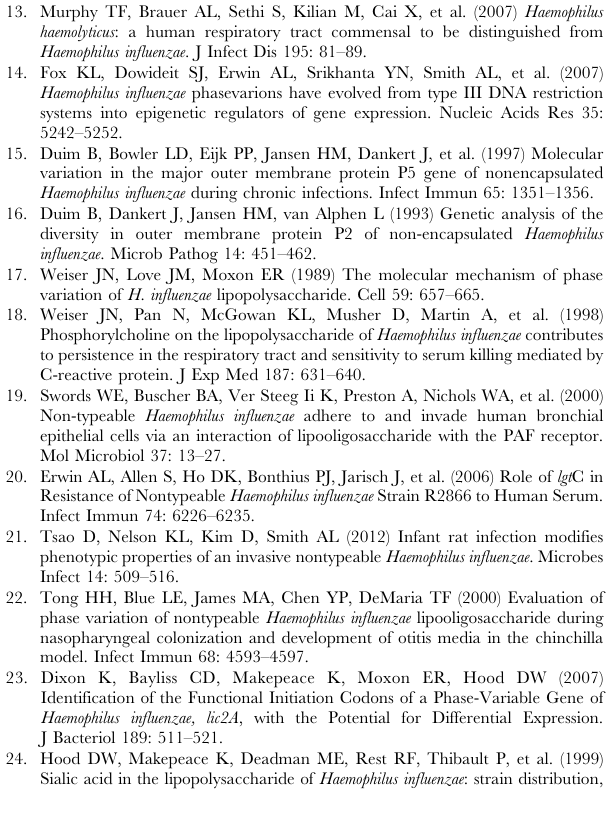
Table S2 Primers used in this study to amplify repeat regions in phase variable LOS genes. Table S3 Primers used in this study to amplify other genes. OMP P6 gene, DNA Recognition Domain (DRD) of modA gene, OMP P2 gene, and OMP P5